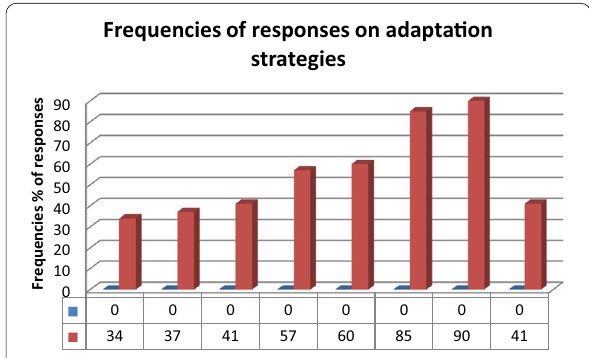
Fig. 7 Frequencies of respondents on coping and adaptation